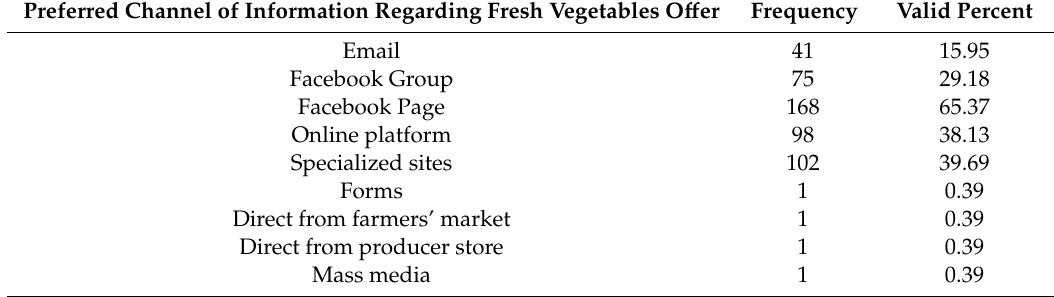
Table 4. The frequency of the preferred channels for gathering information on the o ff er of fresh vegetables (N =